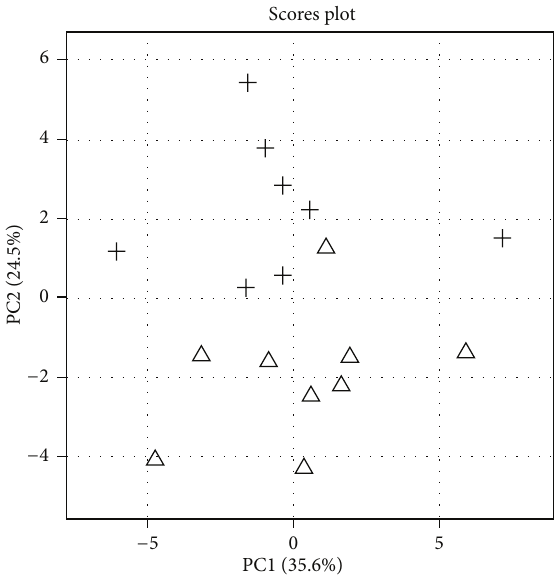
Figure1:PCAplotofoxylipindatainstudymiceplasma.PCAscore plot of plasma oxylipin data from all study samples revealed general clusters in CIA mice samples and Ctrl samples. The individual samplesweremarkedwith“ △ ”or“+”toshowthegroup(CIAversus Ctrl)